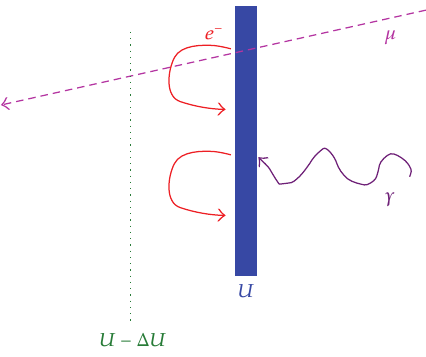
Figure 22: Principle of electrical screening of a surface at high voltage 𝑈 by a nearly massless wire electrode at a slightly more negative voltage 𝑈 − Δ𝑈 . Secondary electrons, which are emitted from the surface at potential 𝑈 —for example, by the interaction of cosmic muons or 𝛾 radiation by environmental radioactivity— will be reflected by the wire potential back to the wall, if the kinetic energy of the secondary electrons is not sufficient to pass the electrical potential barrier 𝑈 − Δ𝑈 . If the wire electrode has a sufficiently small cross-section, the probability that unscreened secondary electrons emitted from the wires is small.